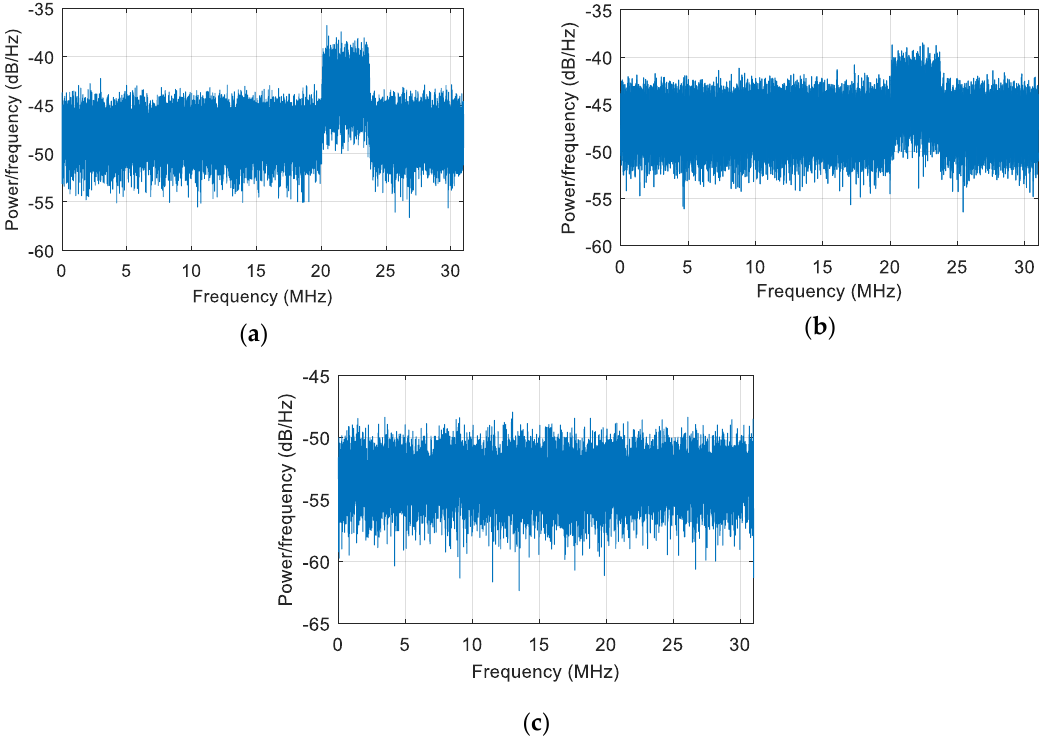
Figure 22. The power spectral density of the signal. ( a ) The signal power spectral density obtained by the original spatial filtering; ( b ) the signal power spectral density obtained by the spatial filtering after the first projection; ( c ) the signal power spectral density obtained by spatial filtering after dual projection.